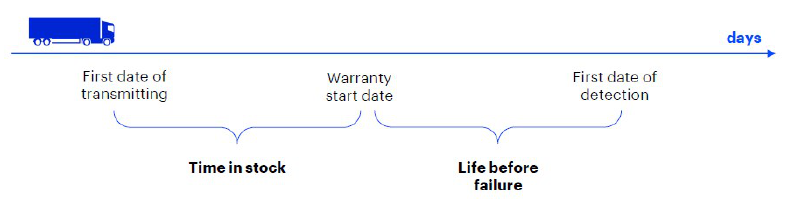
Figure 5. Relevant periods of truck life.